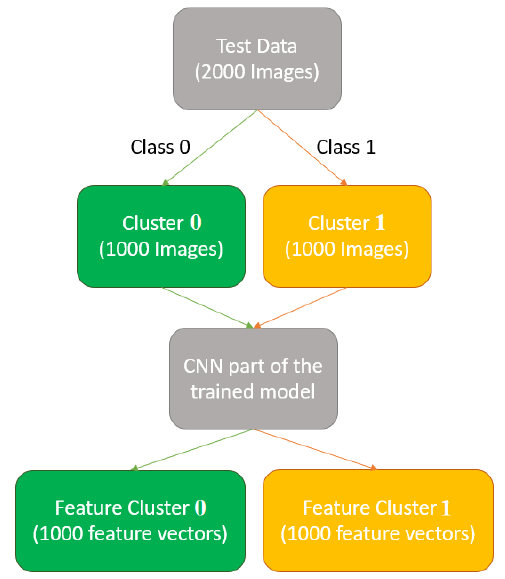
Figure 3. The process of cluster and feature